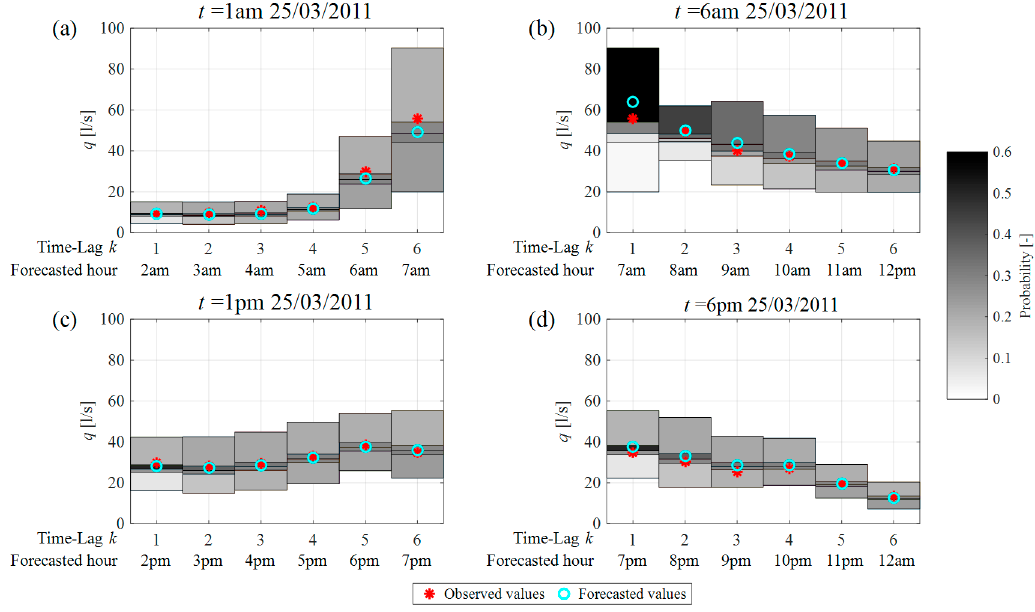
Figure 6. Probabilistic demand forecasts obtained by using model HMC model applied to DMA1 at following times: ( a ) 1 a.m. (with forecasts made from 2 a.m. to 7 a.m.); ( b ) 6 a.m. (with forecasts from 7 a.m. to 12 p.m.); ( c ) 1 p.m. (with forecasts 2 p.m. to 7 p.m.) and ( d ) 6 p.m. (with forecasts from 7 p.m. to 12 a.m.).